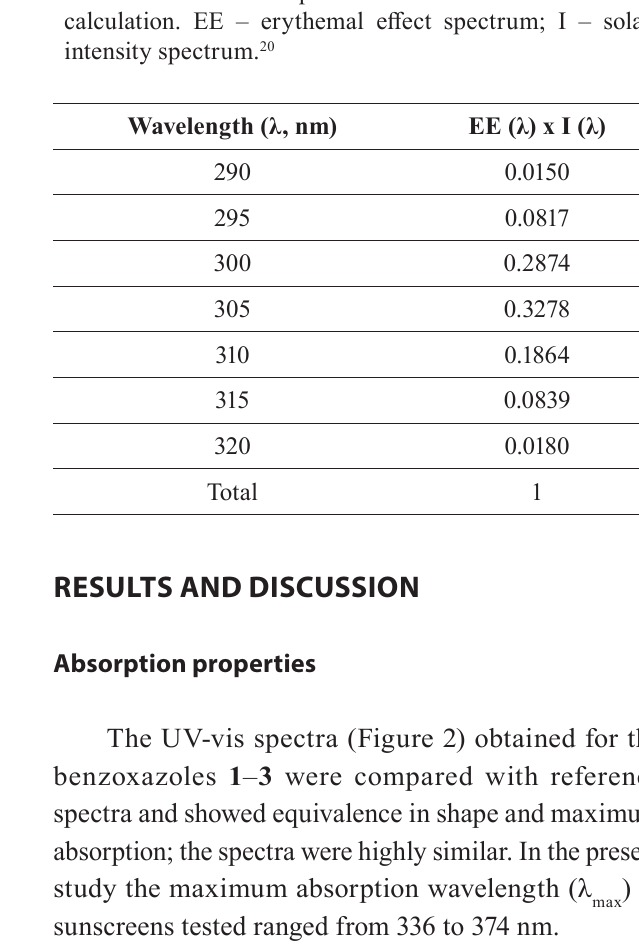
TABLE I - N ormalized product function used in the